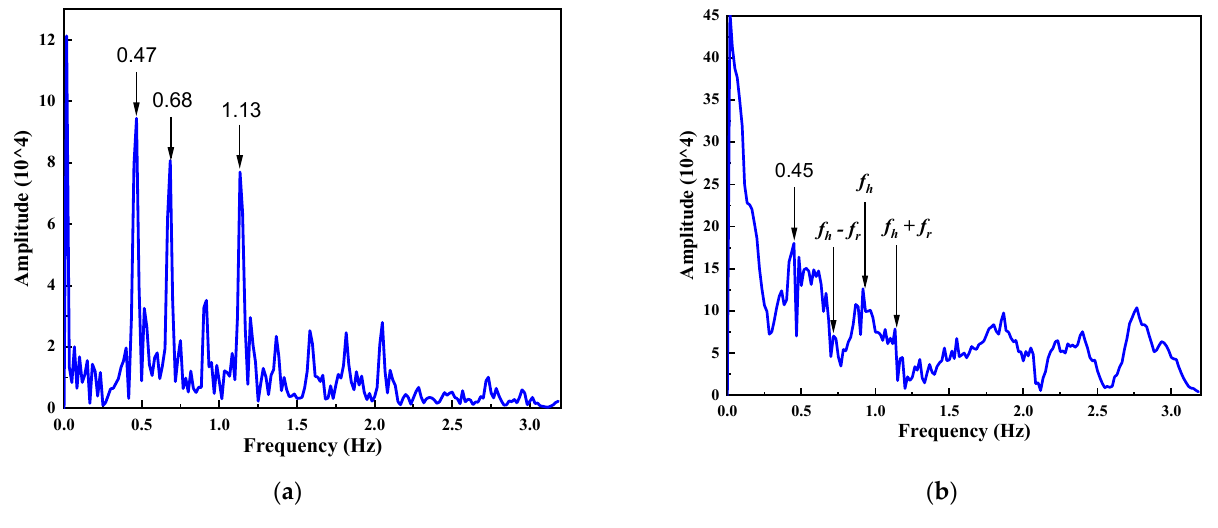
Figure 8. The spectrum of 60 s data in two sleeping states: ( a ) the state of lying down, where the 0.47 Hz RR-related peak and 0.68 Hz and 1.13 Hz HR-related peaks can be found; ( b ) large-scale movements state, where only the 0.45 Hz RR-related peak is obvious and HR-related peaks are drowned out by movement noise (the ground truth of HR is 56 bpm, i.e., 0.93 Hz).